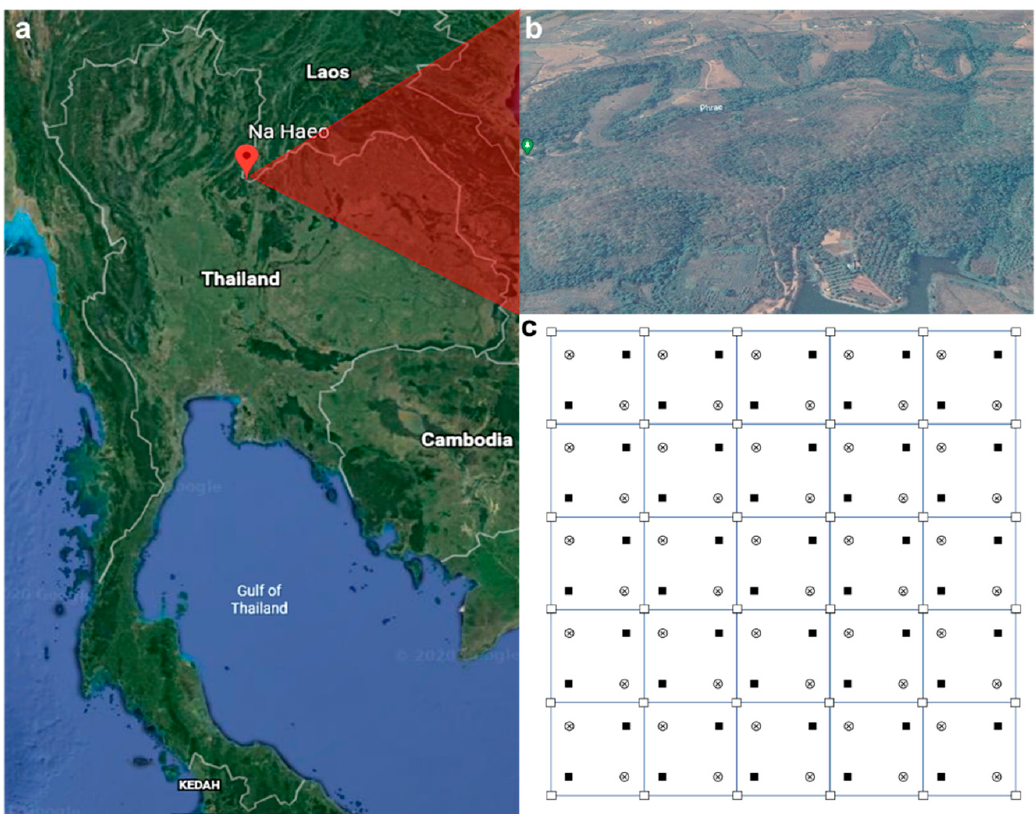
Figure 5. Satellite map of Thailand shows the location of the study site at Na Haeo district, Loei province, Thailand ( a ); Na Haeo Forest Reserve (17°29 ′ N, 101°04 ′ E) ( b ); and the 25 experimental plots (20 m × 20 m each, total area 10,000 m 2 ) ( c ). The symbols , , and indicate 36 seed traps (0.5 m × 0.5 m), 50 subplots for soil sampling (20 cm × 20 cm × 5 cm), and 50 subplots for seedling emergence (1 m × 1 m), respectively.